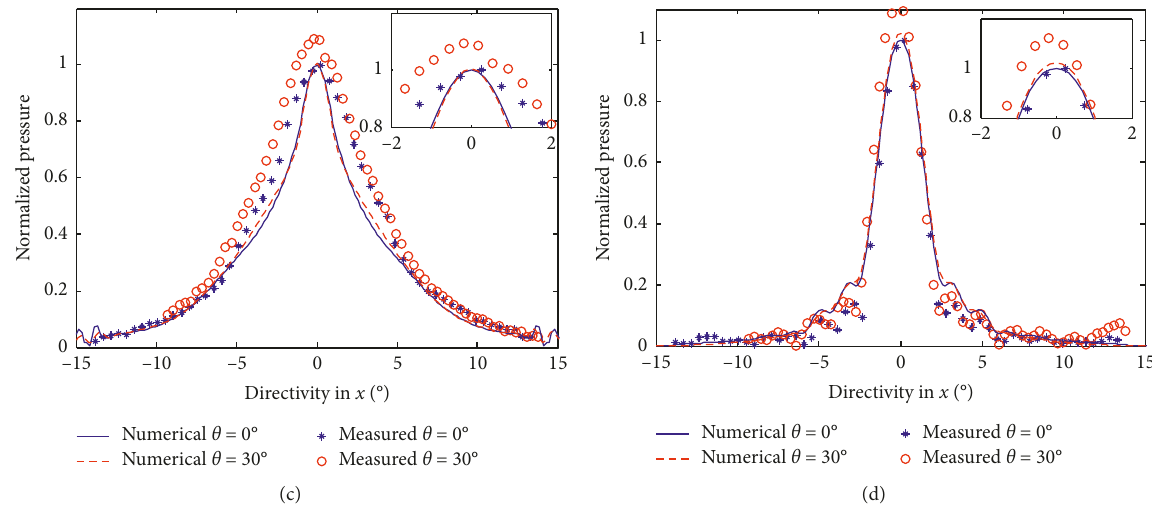
Figure 7: Thedirectivityofsoundpressureat4mawayfromthesoundsourcewithaluminumplate.(a)Theprimarysoundpressure f � 95kHz;(b) theprimarysoundpressure f � 110kHz;(c) thedifferencefrequency soundpressure f � 15kHz;(d)thesumfrequencysoundpressure f � 205kHz.